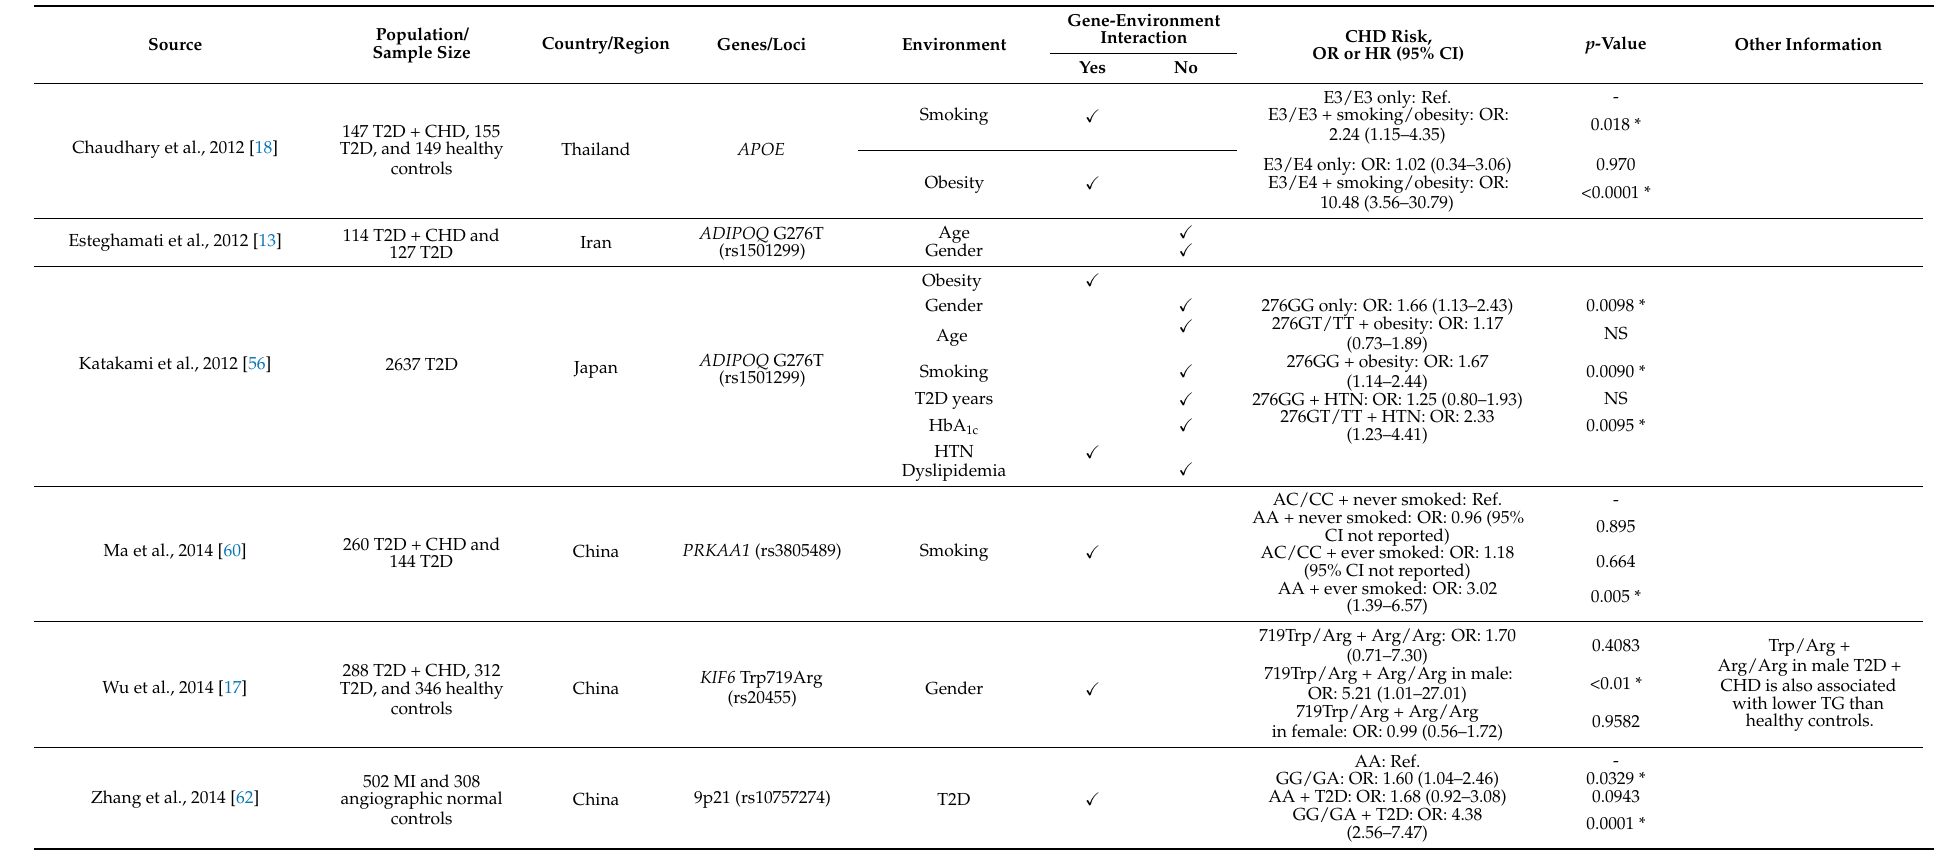
Table 4. Gene-environment interactions and their associations with CHD in T2D